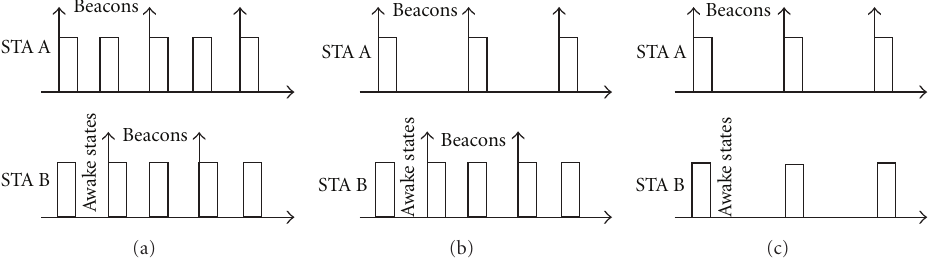
Figure 14: Wake-up patterns of STA A and STA B for di ff erent link specific power modes. (a) Link A → B light sleep and Link B → A light sleep. (b) Link A → B deep sleep and Link B → A light sleep. (c) Link A → B deep sleep and Link B → A listens only A’s beacon. STA B transmits no beacon.